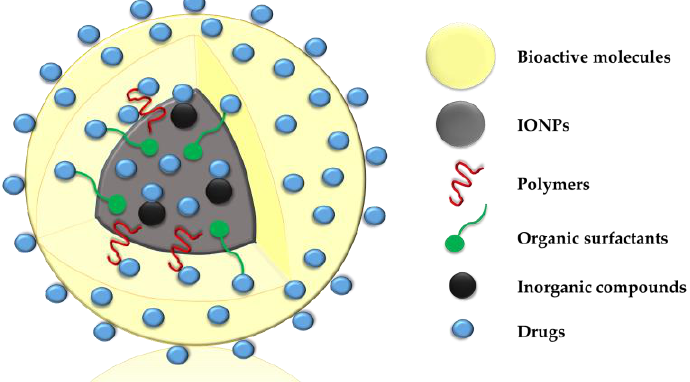
Figure 2. Schematic illustration of drugs directly bound to iron oxide nanoparticles (IONPs) or to core-shell nanosystems.